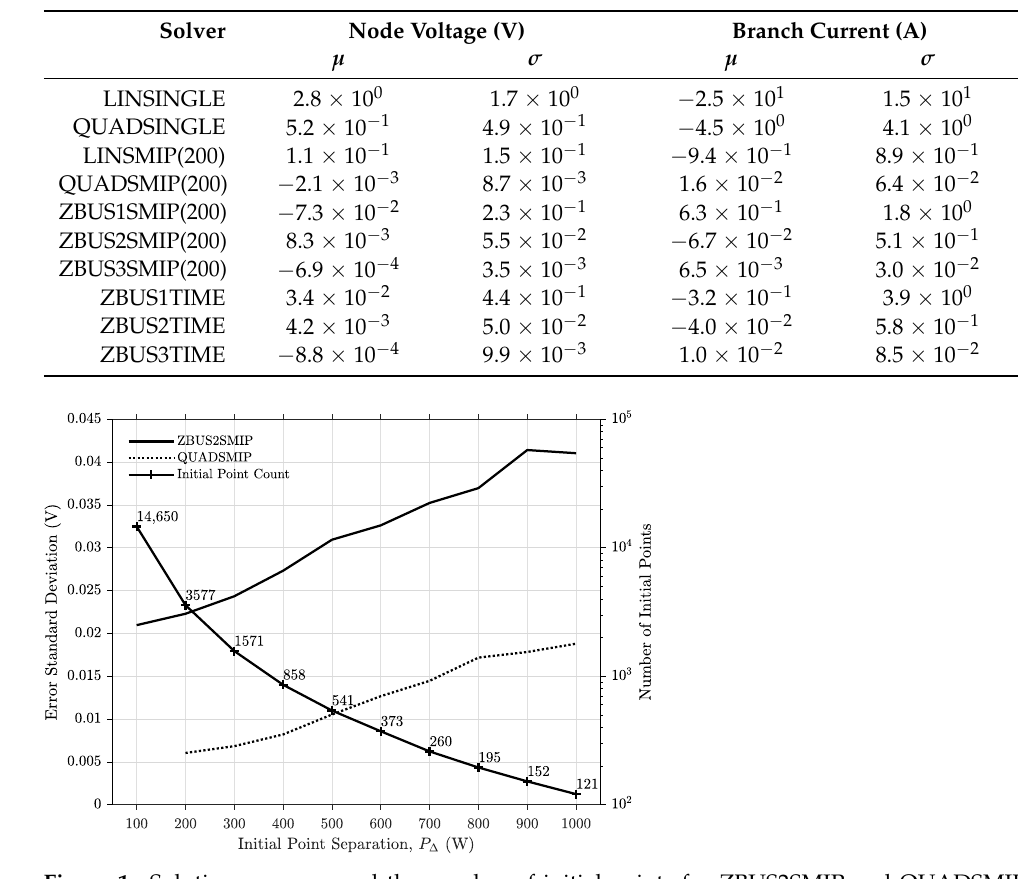
Figure 1. Solution accuracy and the number of initial points for ZBUS2SMIP and QUADSMIP methods as a function of initial point separation.